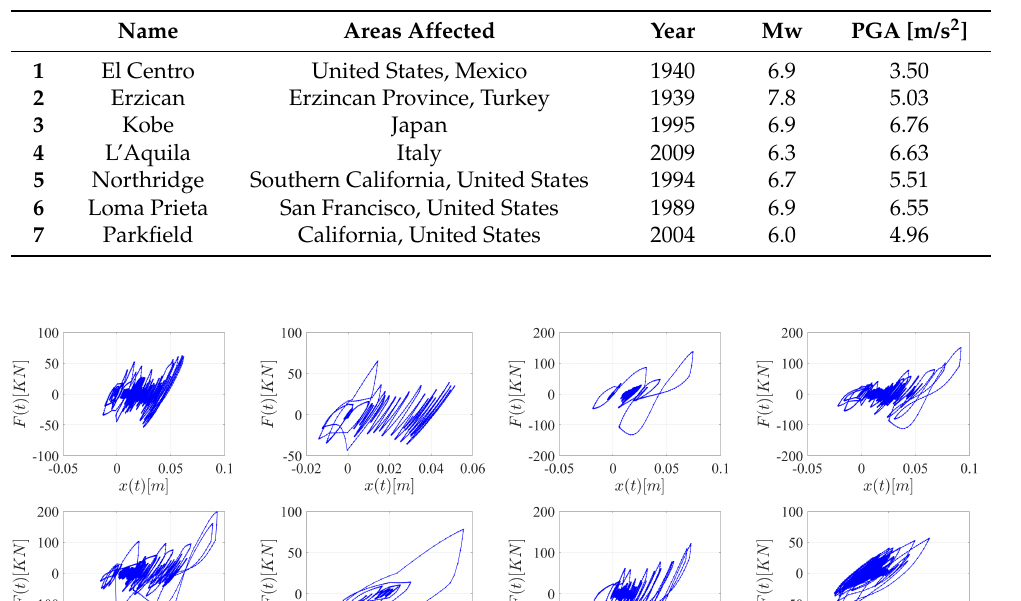
Table 3. List of the earthquakes adopted in the analysis.